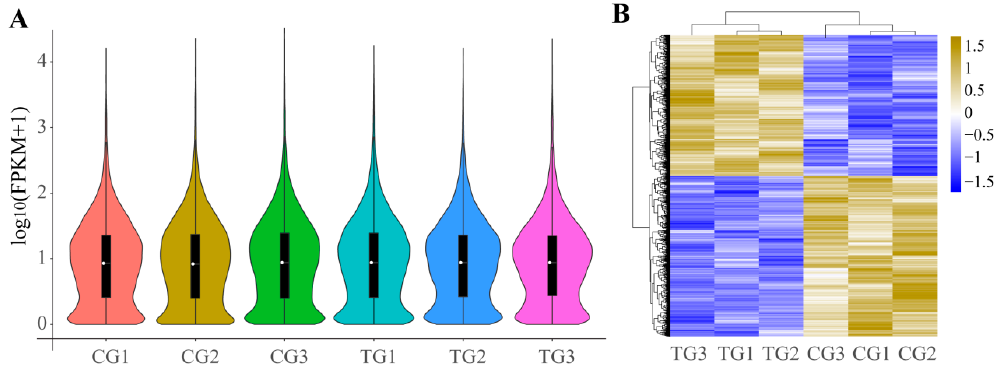
Figure 5. ( A ) Expression level indicated by log10 (FPKM + 1) in the mRNAs between control piglets (CG) and treatment group (TG); ( B ) Clustered heatmap of the differentially expressed mRNAs in paired samples of CG and TG. Rows represent mRNAs while columns represent different treated samples.